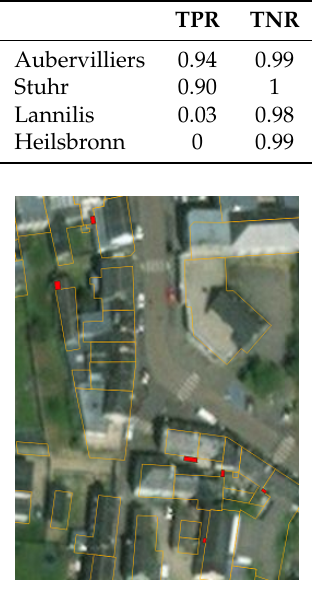
Figure 9. False positives (small building pieces coloured in red) detected by C A + B ∗